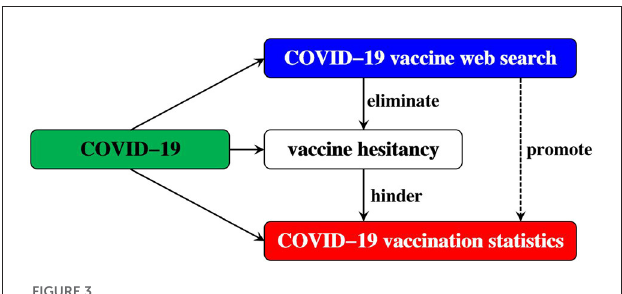
FIGURE3 The process of eliminating COVID-19 vaccine hesitancy through web search.